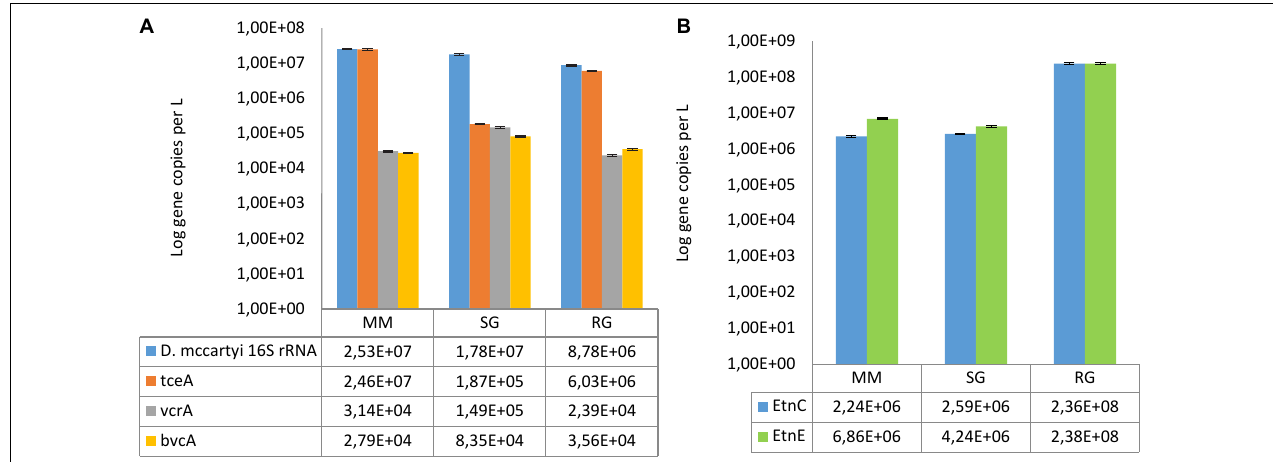
FIGURE 3 | (A) Abundances of Dehalococcoides mccartyi 16S rRNA and the reductive dehalogenase genes (tceA, bvcA, and vcrA) estimated at the outlet of the reductive reactor. (B) Abundances of the functional genes (etnC and etnE) involved in VC oxidation estimated from the outlet of the oxidative reactor. Feeding conditions: Mineral medium (MM), synthetic groundwater (SG), and real groundwater